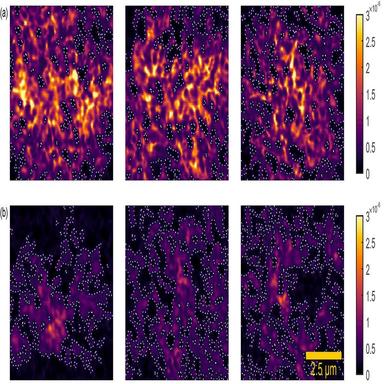
Typical heatmaps of the shared characteristic pattern changes of (a) OPC and (b) LC3 . The heatmap was achieved by iterating over the most similar shared characteristics patterns by deep Taylor decomposition.